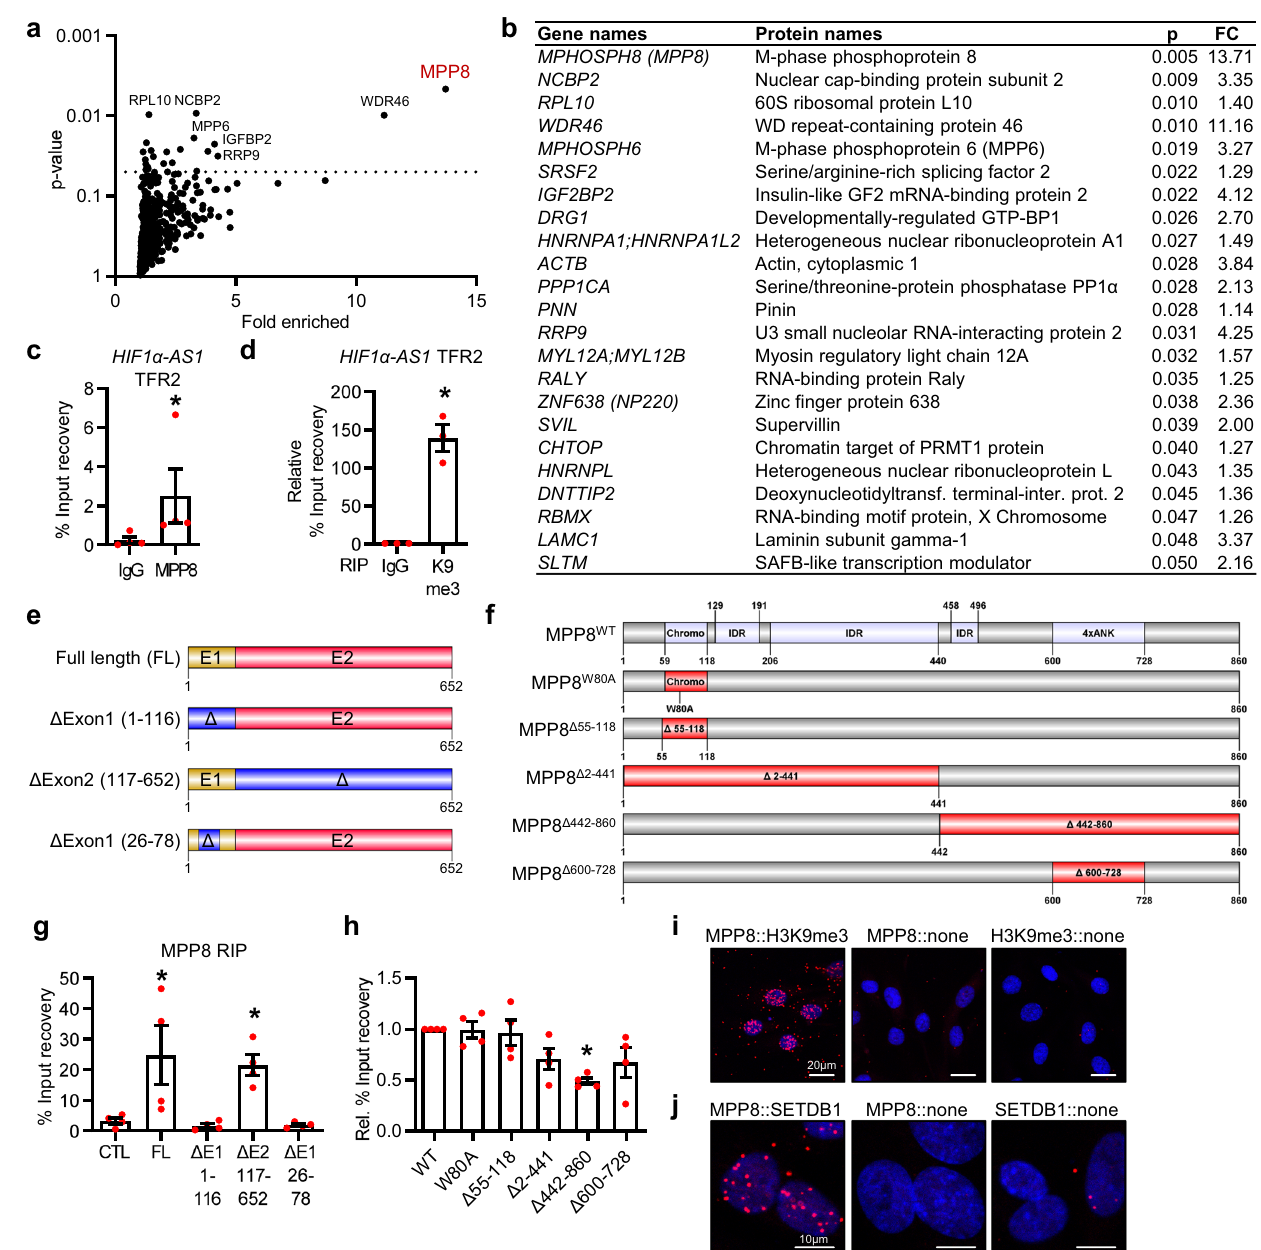
Fig. 5 | HIF1 α -AS1 interacts directly with the HUSH complex member MPP8. a Volcano plot of HIF1 α -AS1 protein interaction partners after RNA pulldown assay and ESI-MS/MS measurements with fold enrichment and p value. n =5. Signi fi cant proteins are shown above the line ( p <0.05). b List of proteins enriched after RNA pulldown assay, their p value (p, unpaired t test, two-tailed) and absolute fold change (FC). c RIP with MPP8 antibodies and qPCR for HIF1 α -AS1 TFR2. IgG served as negative control. n =4 independent experiments, Mann – Whitney test. *( p =0.0286). d RIP with histone3-lysine9-trimethylation antibodies and qPCR for HIF1 α -AS1 TFR2. IgG served as negative control. n =3 independent experiments, Paired t test. *( p =0.0162). e Scheme of the different HIF1 α -AS1 RNAs used for in vitro RNA immunoprecipitation. E1, Exon1; E2, Exon2. f Scheme of the different MPP8 mutants used for in vitro RNA-immunoprecipitation. IDR intrinsically dis- ordered region, ANK Ankyrin repeat; Chromo, Chromodomain. g RT-qPCR after in vitro binding assay of puri fi ed MPP8 with in vitro transcribed HIF1 α -AS1 RNAs.